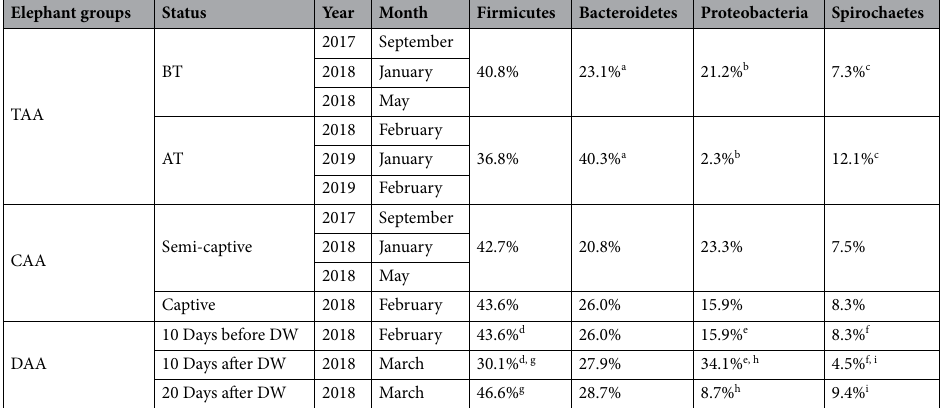
Table 1. The relative abundance of the four most abundant phyla. TAA translocation anthropogenic activity, CAA captivity anthropogenic activity, DAA deworming anthropogenic activity, BT before translocation, AT after translocation, DW deworming. The percentile abundances with the same superscript letter are significantly different (two-Sample t-test, p < 0.01).